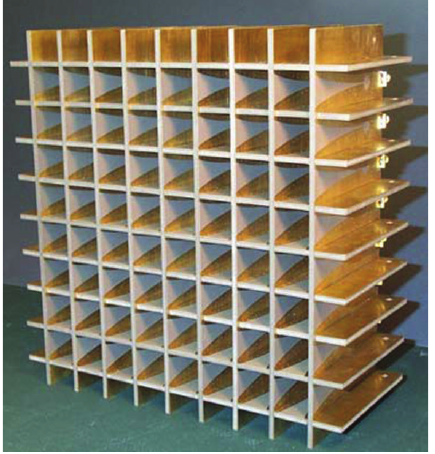
Figure 21: Dual-polarized Vivaldi array [45].